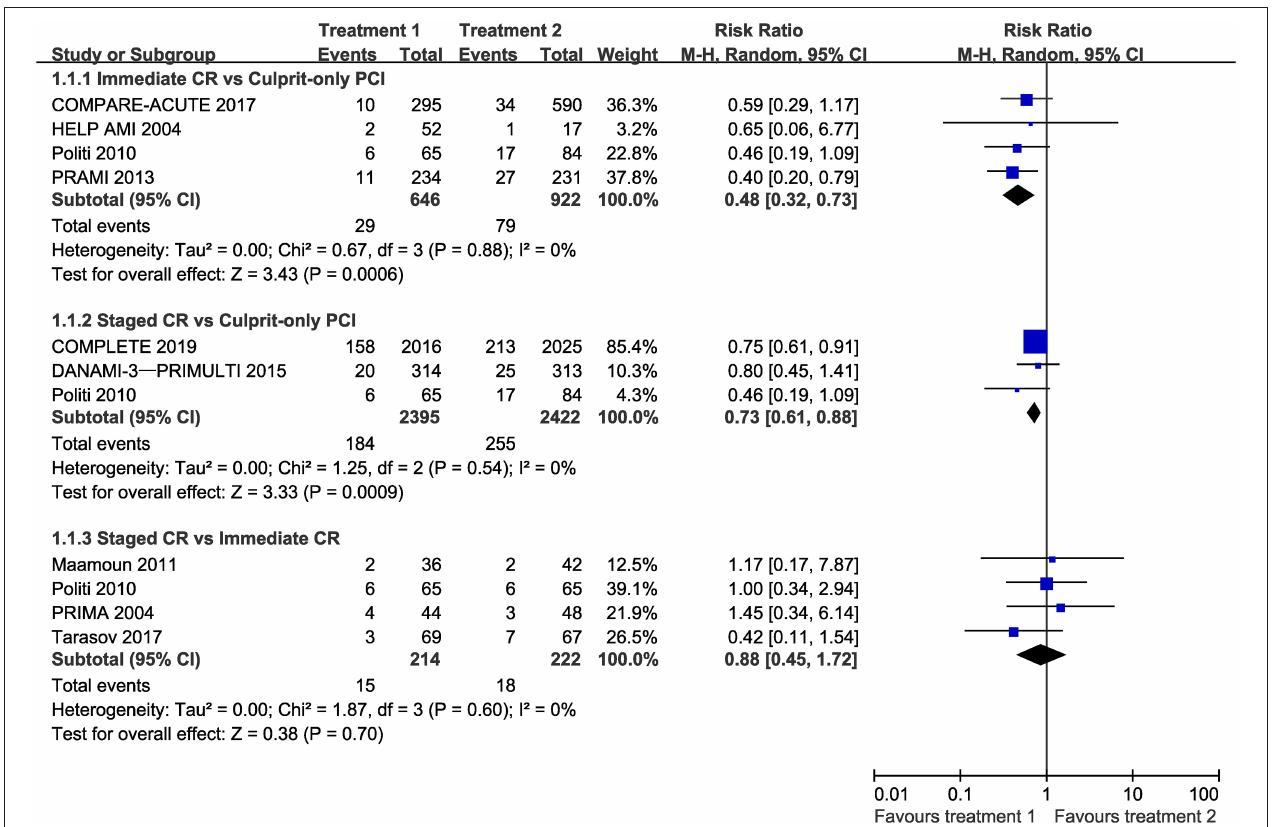
FIGURE 2 | Forest plot of pairwise meta-analysis for cardiovascular mortality or myocardial infarction. CI, confidence interval; CR, complete revascularization; PCI, percutaneous coronary intervention.